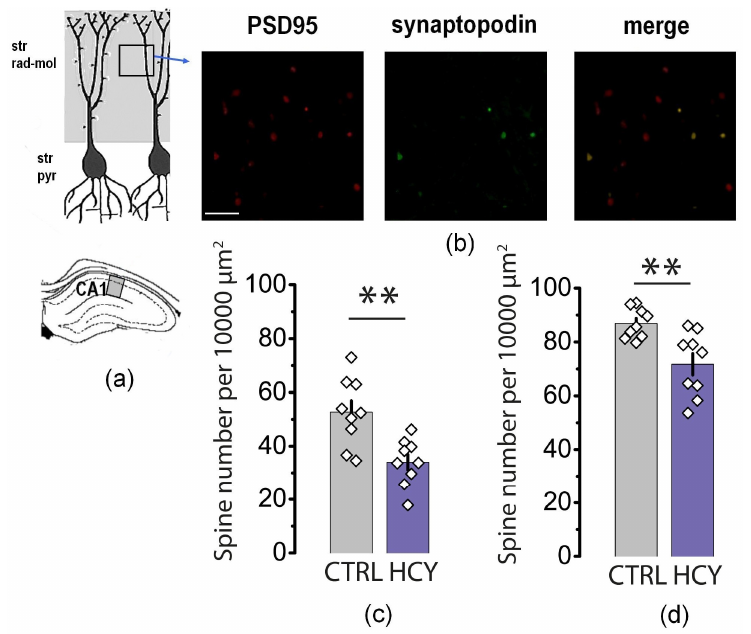
Figure 8. The distribution of actin-associated protein synaptopodin in the stratum radiatum- moleculare in CA1 of dorsal hippocampus. ( a ) Scheme showing the area of interest in stratum radiatum-moleculare of CA1. ( b ) Distribution of an actin-associated protein synaptopodin (green) and postsynaptic protein PSD95 (red) in the hippocampus of control rat at P20. Scale bar = 10 µ m. ( c , d ) Diagrams showing the average number of synaptopodine-positive clusters in the hippocampus of P20 ( c ) and P90 ( d ) control and HCY rats. ** p < 0.01, unpaired two-tailed Mann-Whitney U -test. We first confirmed that synaptopodin was localized in postsynaptic density, for which slices were double stained for synaptopodin and the postsynaptic marker protein PSD95. The results showed that all synaptopodin clusters were colocalized with PSD95- positive spots (Figure 8b), confirming that synaptopodin-positive specks corresponded to dendritic spines.